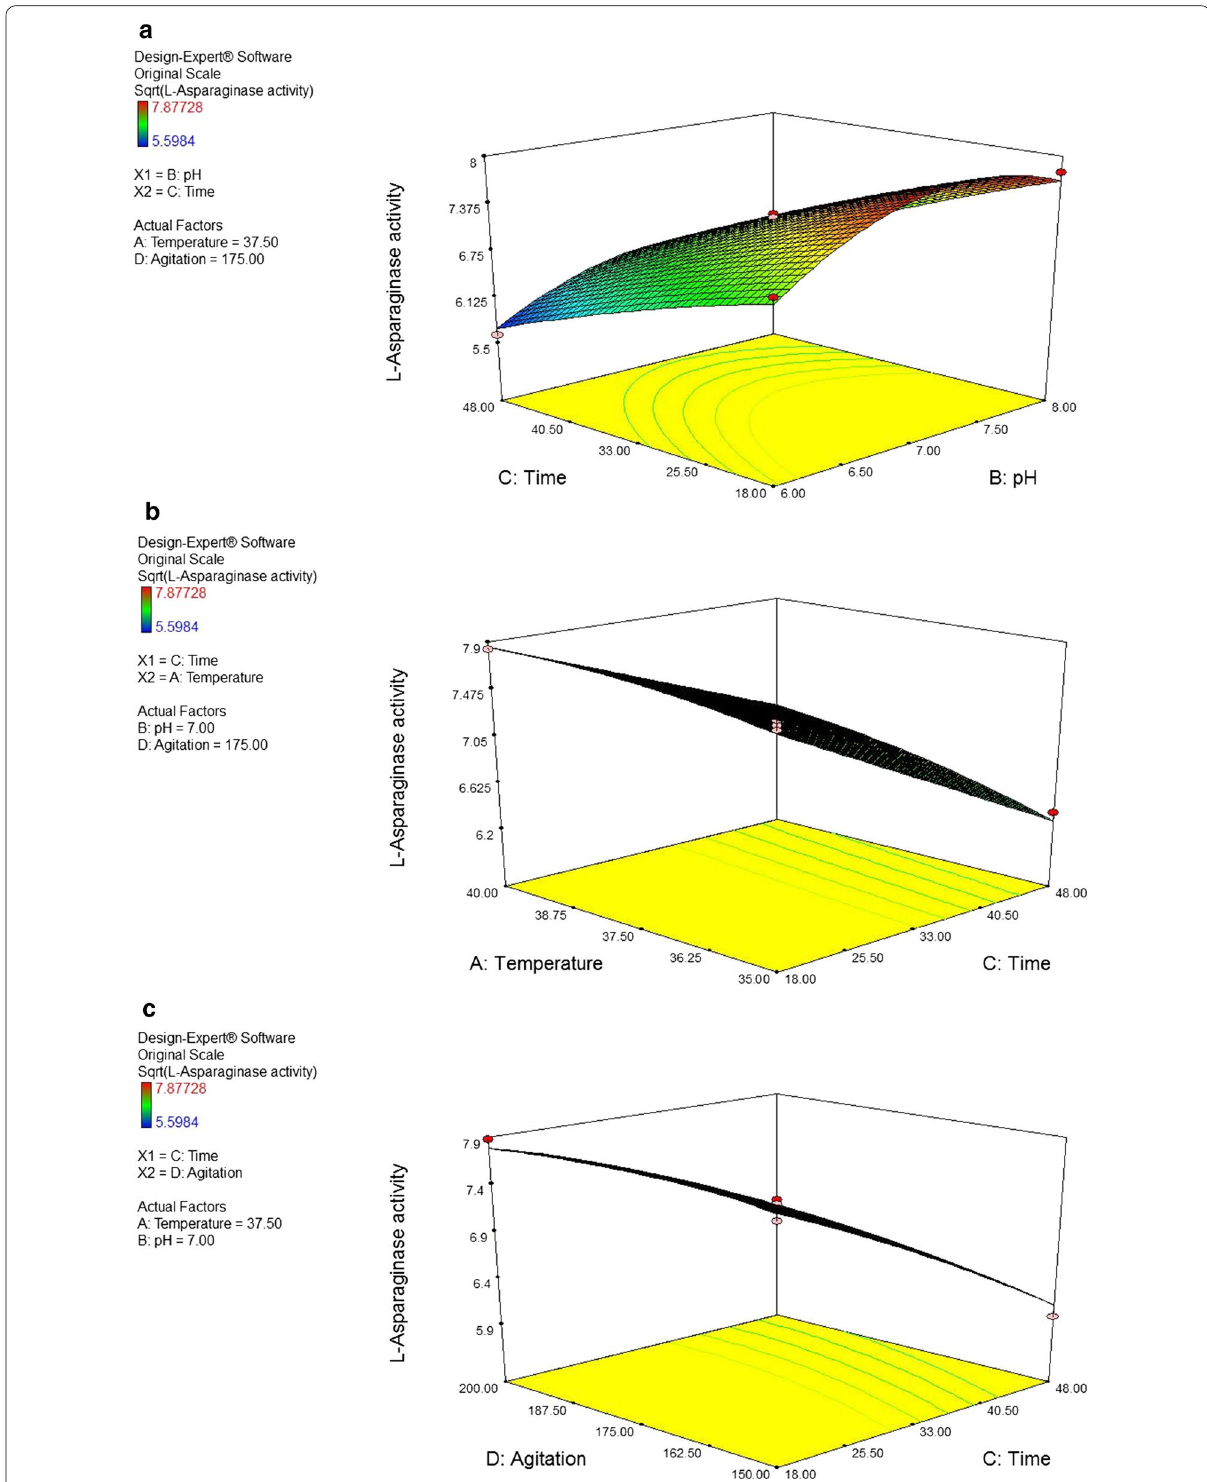
Fig. 6 Response surface plots for the optimization of process parameters showing the effect of a the interaction between pH and time (h); b the interaction between time (h) and temperature (°C); and c the interaction between time (h) and agitation (rpm) on l -asparaginase production by Bacillus licheniformis mutant strain. The enzyme productivity was expressed in terms of catalytic